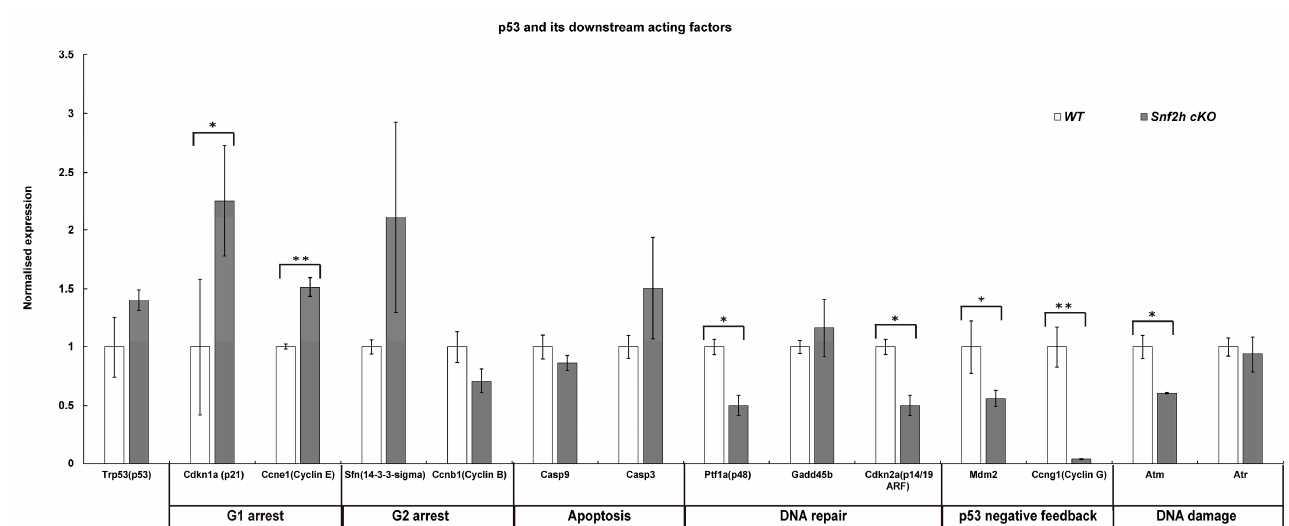
Figure 8. Quantification of mRNA expression of p53 downstream acting factors at P0 assessed with qRT-PCR. Whole retinae from P0 wild-type and Snf2h cKO eyes were dissected, subjected to RNA isolation, and processed using qRT-PCR. A total of 3 retinas were tested. Error bars indicate standard derivation; p -values were calculated using Student’s t -test ( n = 3). * p < 0.05, ** p < 0.01.